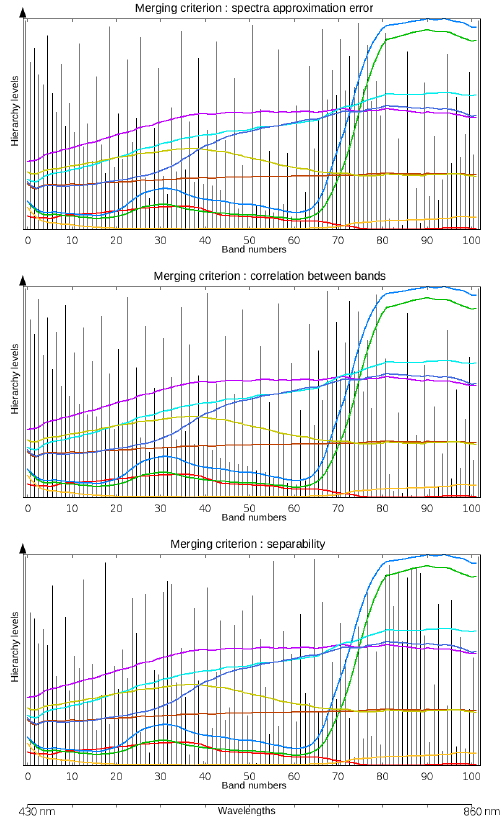
Figure 3: Hierarchies of merged bands obtained for different cri- teria for Pavia data set: spectra piece-wise approximation error (top), between band correlation (middle) and class separability (bottom). x-axis corresponds to the band numbers/wavelengths. y-axis corresponds to the level in the band merging hierarchy (bottom : finest level with original bands, top : only a single merged band). Vertical black lines are the limits between merged bands : the lower in the hierarchy, the more merged bands. Ref- erence spectra of the classes are displayed in colour.